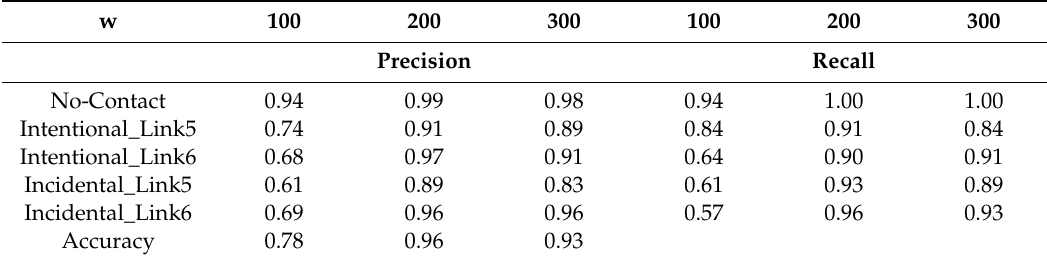
Table 3. Precision and recall of trained networks for contact detection with di ff erent window size. w